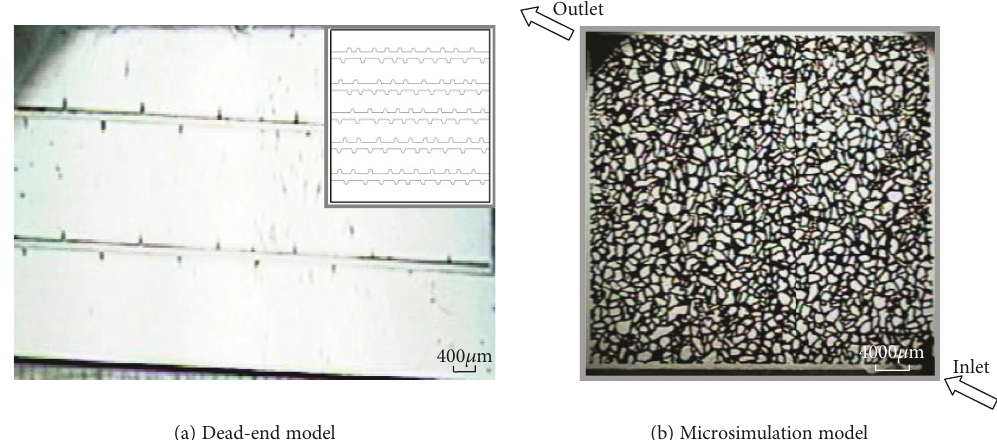
Figure 2: Etched-glass physical models (both of the models are saturated with oil, the dark area represents oil, and the light area represents glass).